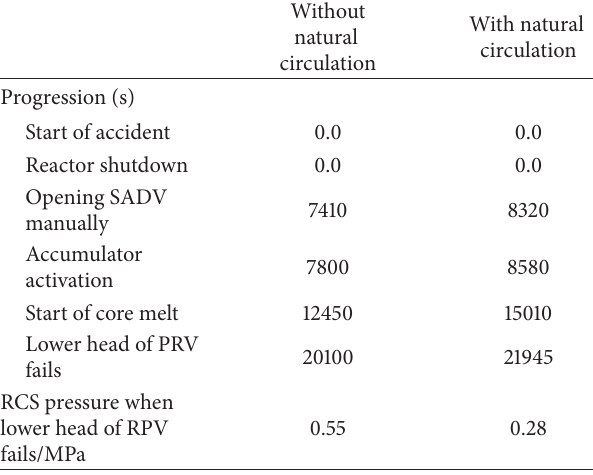
Table 2: Comparison of RCS depressurization progression for TMLB’